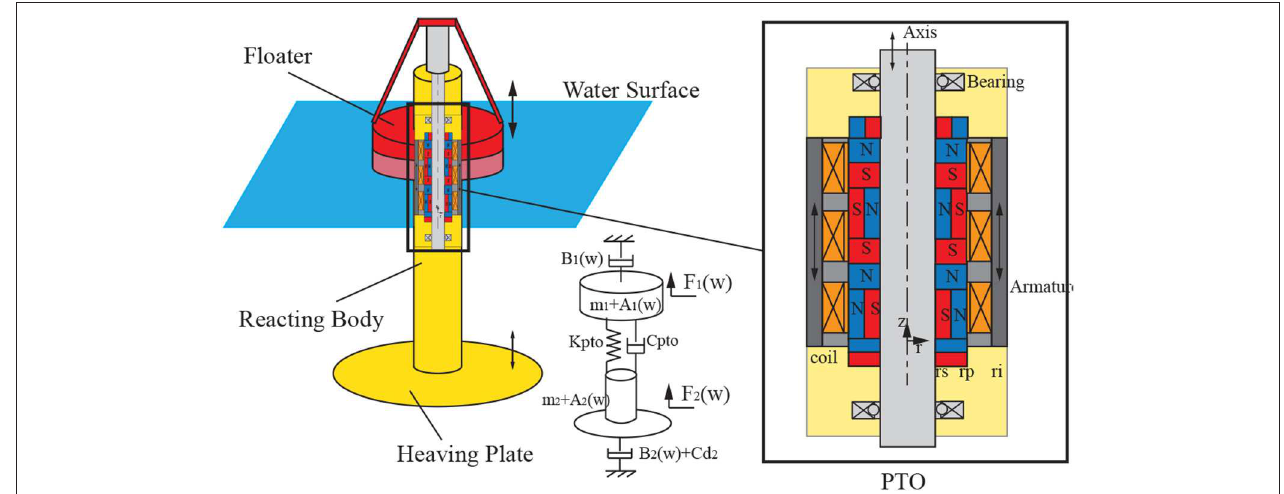
FIGURE 1 | Scheme of the self-reacting point